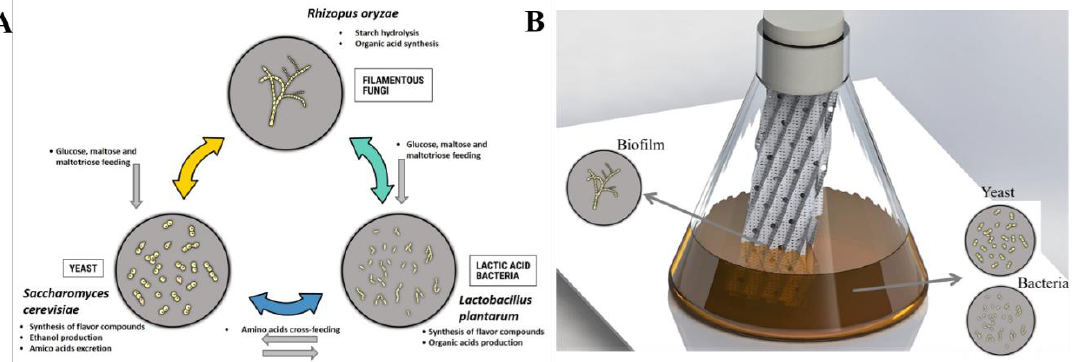
Figure 4. Scheme showing microbial interaction in biofilm cultivation device. ( A ) hypothetical metabolic interactions between fungi, yeast, and LAB, and the resulting functions during red rice wine fermentation (or on the synthetic liquid medium). ( B ) Scheme showing the biofilm cultivation device used in this study, i.e., a shake flask with a stainless steel packing sheet, as well as the expected positions of fungi, yeast, and LAB species during